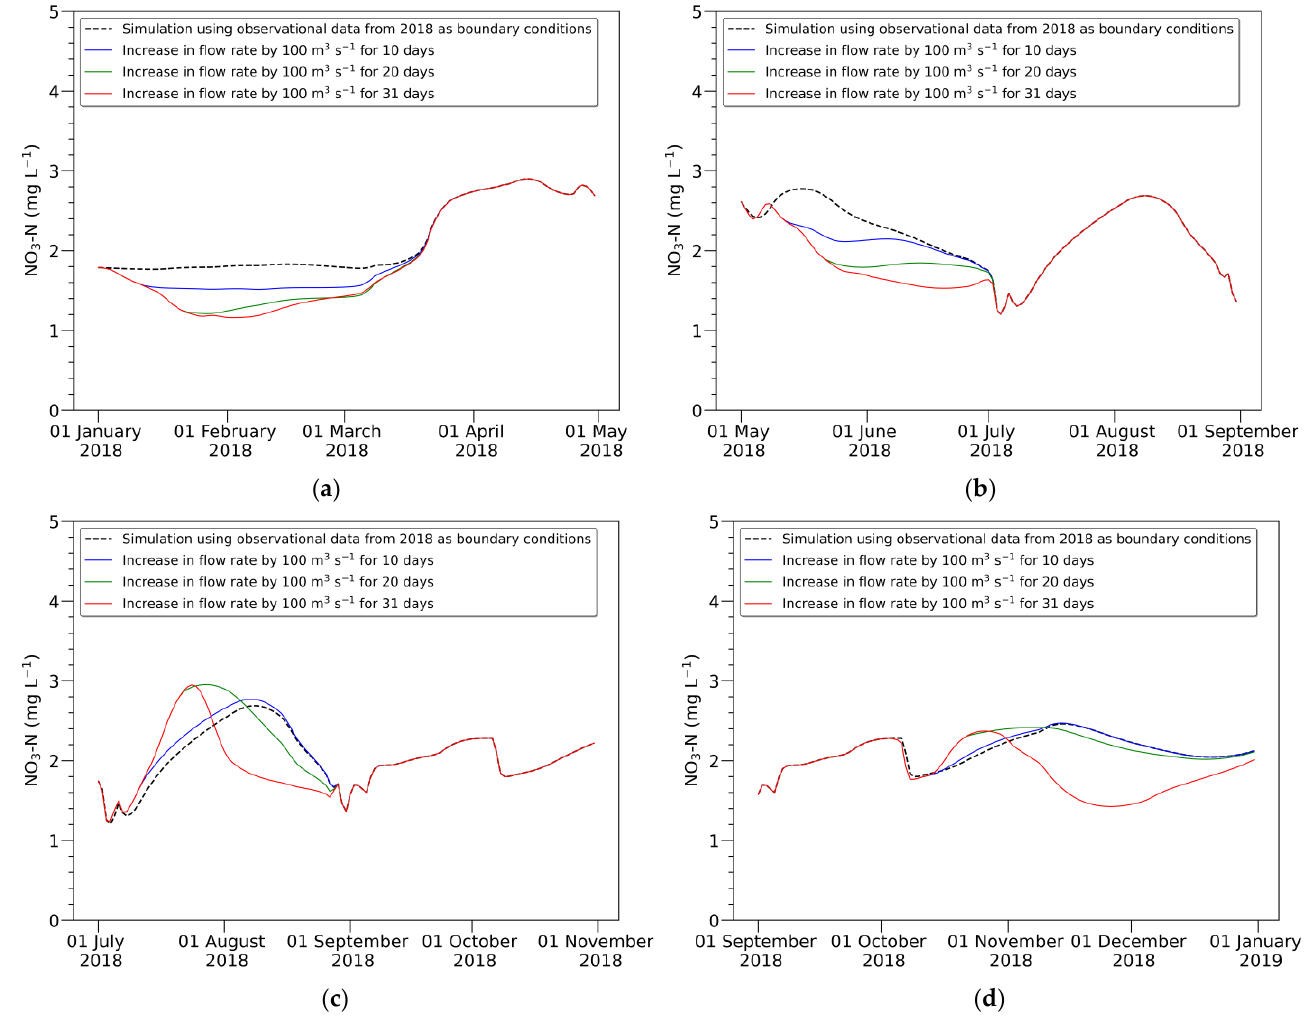
Figure 11. Changes in the NO 3 -N concentration in cross section 416 caused by variations in flow rate (100 m 3 s − 1 ) at the upstream boundary for 10, 20, and 31 days. The black graph shows the NO 3 -N concentration simulated using the observational data from 2018 as boundary conditions. The change in flow rate occurred in: ( a ) January; ( b ) May; ( c ) July; and ( d ) October.